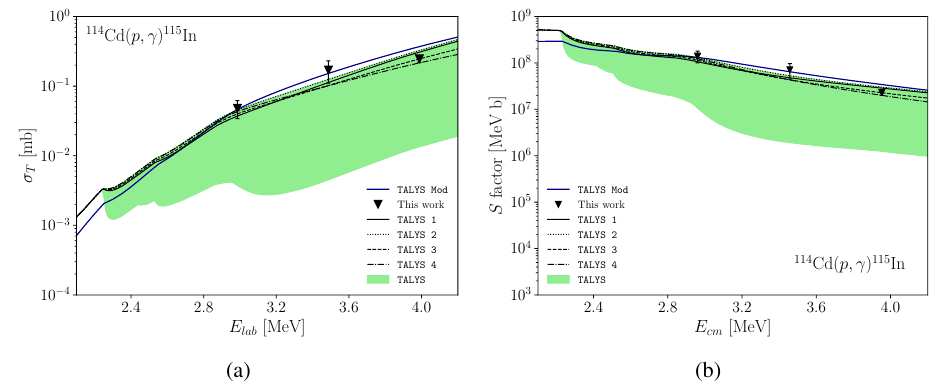
Figure 4: Same as in Fig. 3, for the reaction 114 Cd( p , γ ) 115